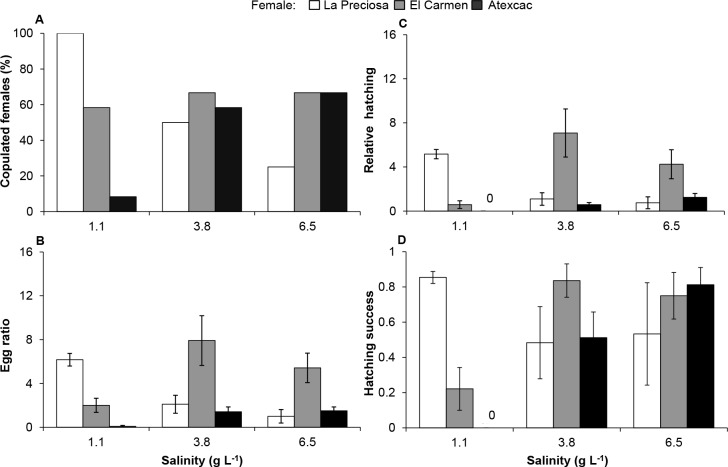
Intra-population mating at home and alternative salinities.(A) Percentage of copulated females (spermatophore attached to the genital pore). (B) Egg ratio (number of eggs/number of females); (C) Relative hatching (number of nauplii/number of females); (D) Hatching success (nauplii/eggs). Values are mean ± SE.